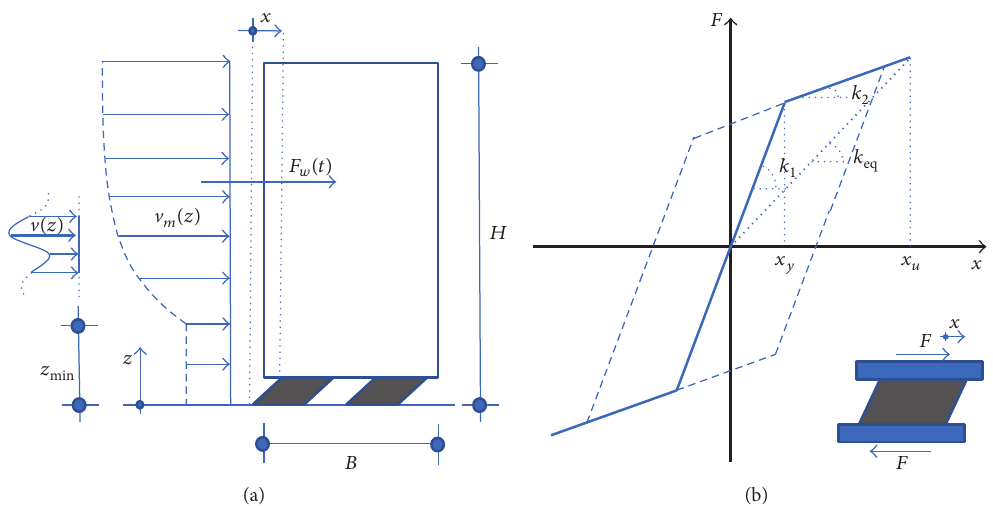
Figure 1: Simplified mechanical system for comfort parametric analysis under wind loading: sketch of the wind-excited base isolated building (a) and constitutive behavior of the base isolation devices